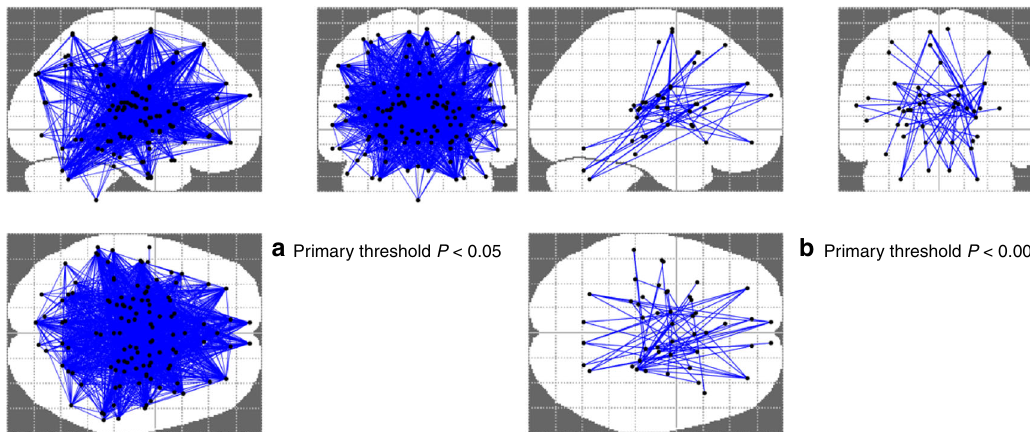
Fig. 4 Regions identi fi ed as showing signi fi cantly greater covariance in schizophrenia compared to healthy controls. Using a primary threshold of p < 0.05 (false discovery rate corrected), a global increase in connectivity was shown in schizophrenia (left-hand side). A more conservative ( p < 0.001 false discovery rate corrected) threshold identi fi ed the most signi fi cant components to be in a cerebello-thalamo-cortical network ( b , right-hand side)